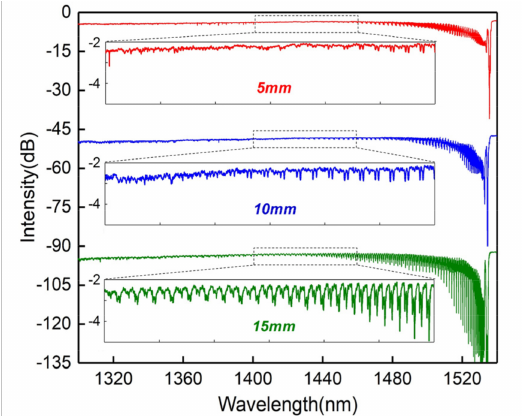
Figure 3. Transmissions of a cladding mode FBG (CMFBG) versus di ff erent grating lengths, inset: magnified spectrum from 1400 to 1460